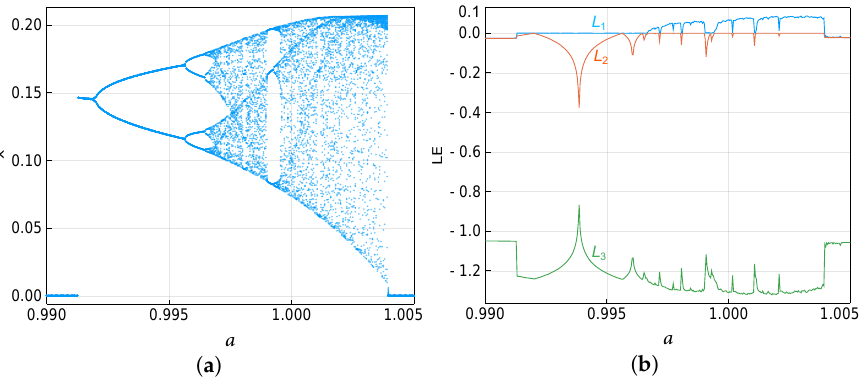
Figure 6. ( a ) Bifurcation diagram, and ( b ) Lyapunov exponents spectrum versus a of system